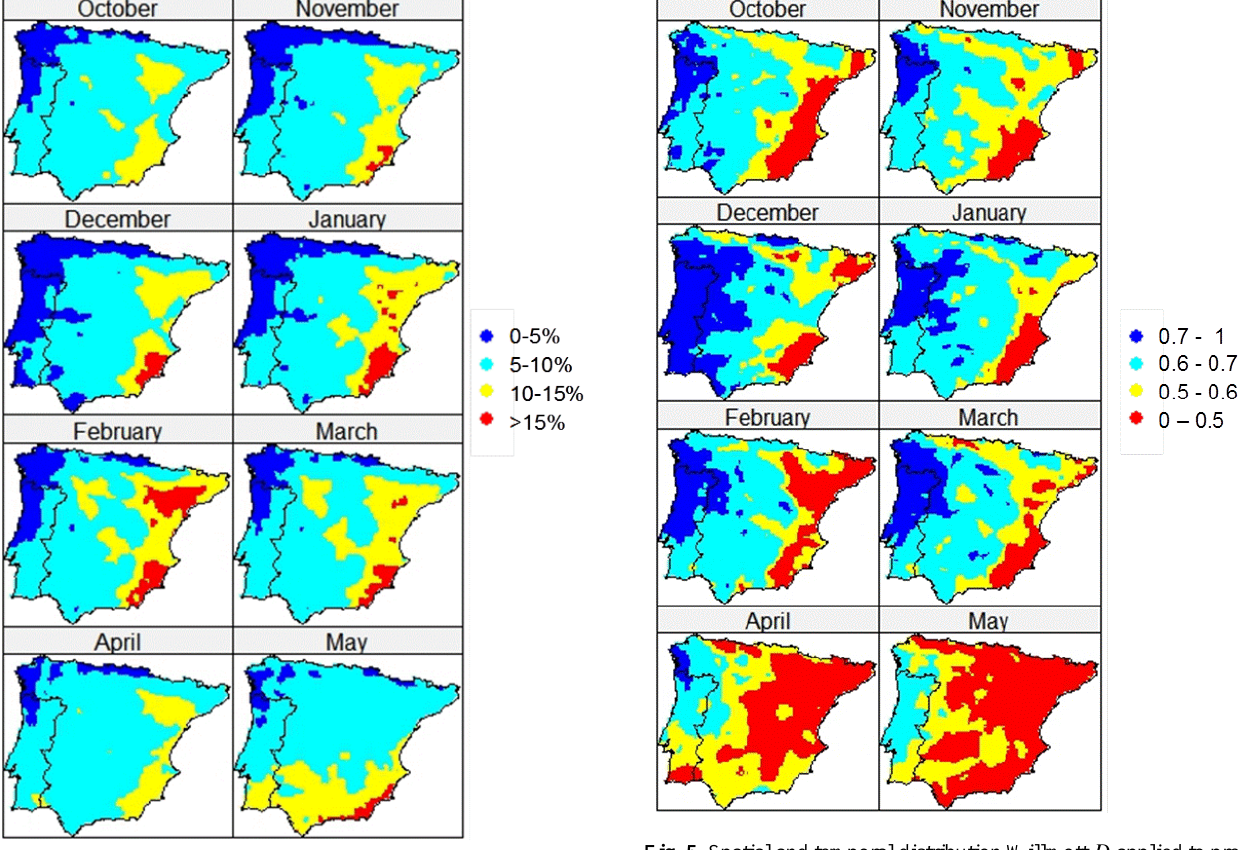
Figure 4. Spatial and temporal distribution of MAE of predicted rainfall amount for each month from October to May normalized for the mean monthly observed precipitation. Low percentages represent a better agreement between reconstruction and observations.